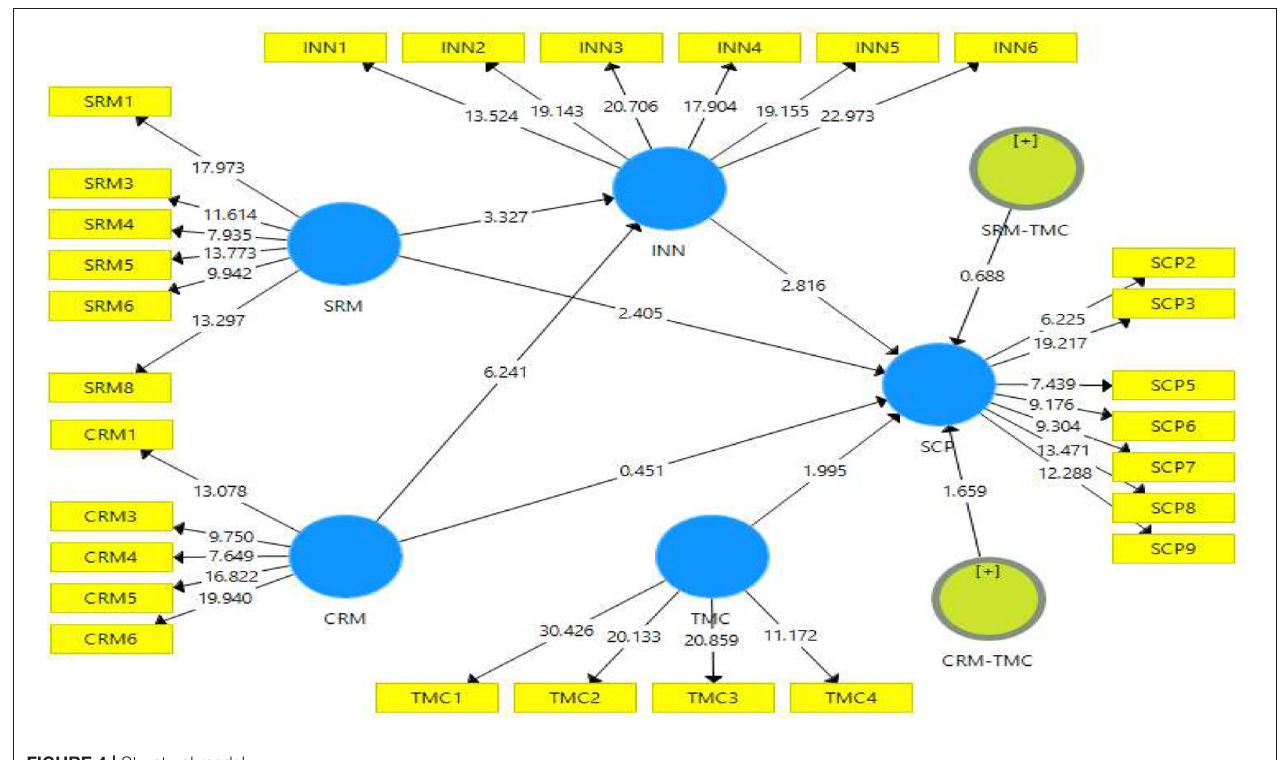
FIGURE 4 | Structural model.